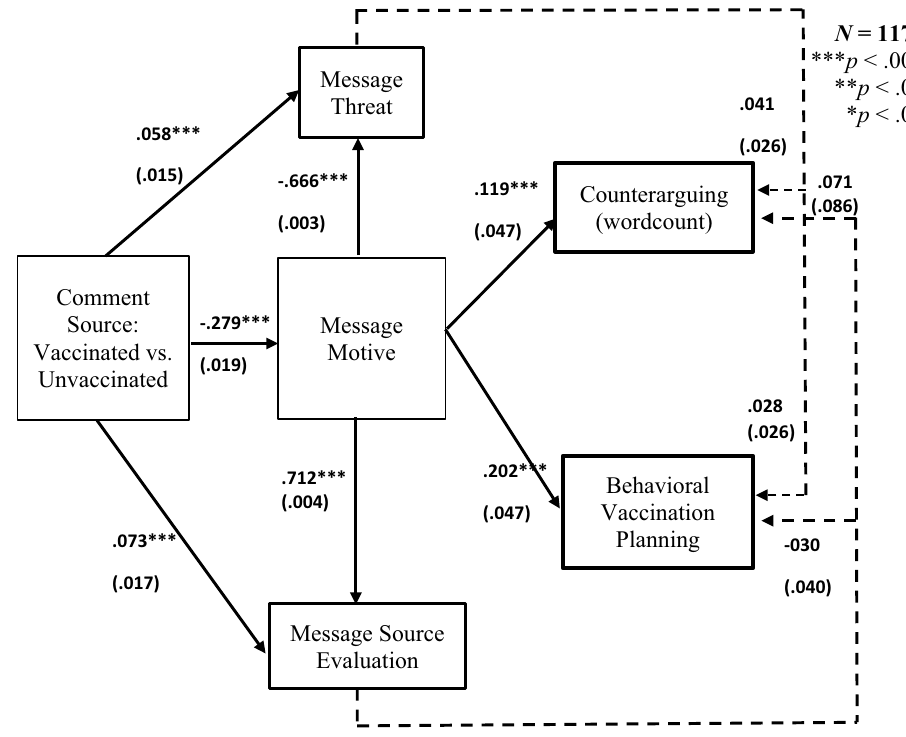
Figure 3. Results of structural equation model analyses. Dashed lines are non-significant paths. Estimates are standardized regression coefficients and SEs in parentheses.